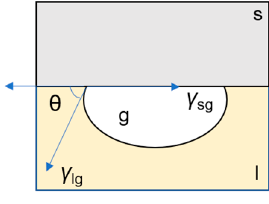
Figure 1. Contact angle ( θ ) and surface tensions ( γ ) of gas bubble (g) in liquid (l) underneath the solid (s).